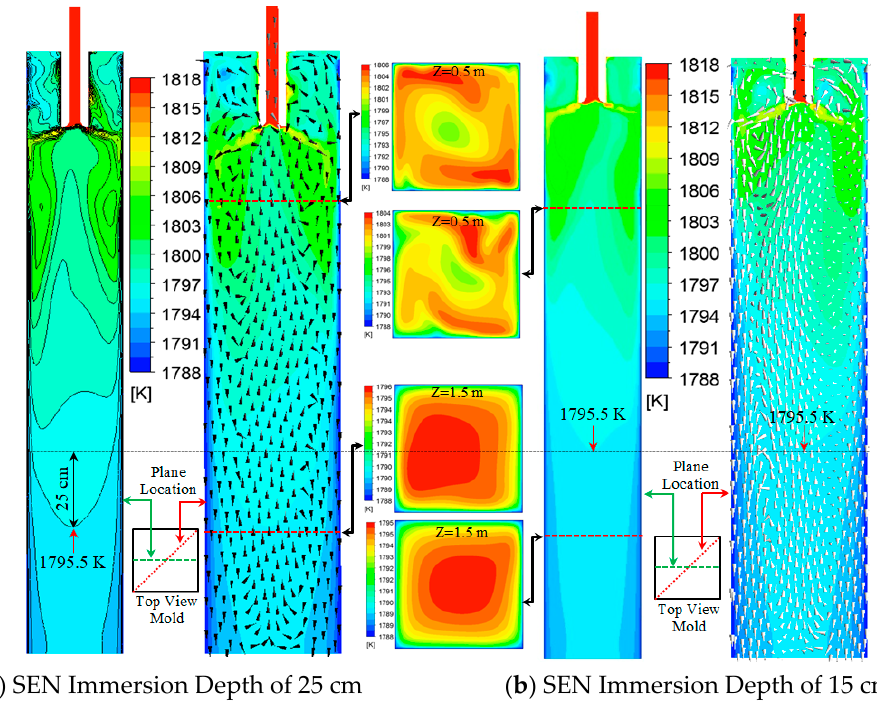
Figure 11. Temperature distribution in mold for different SEN immersion